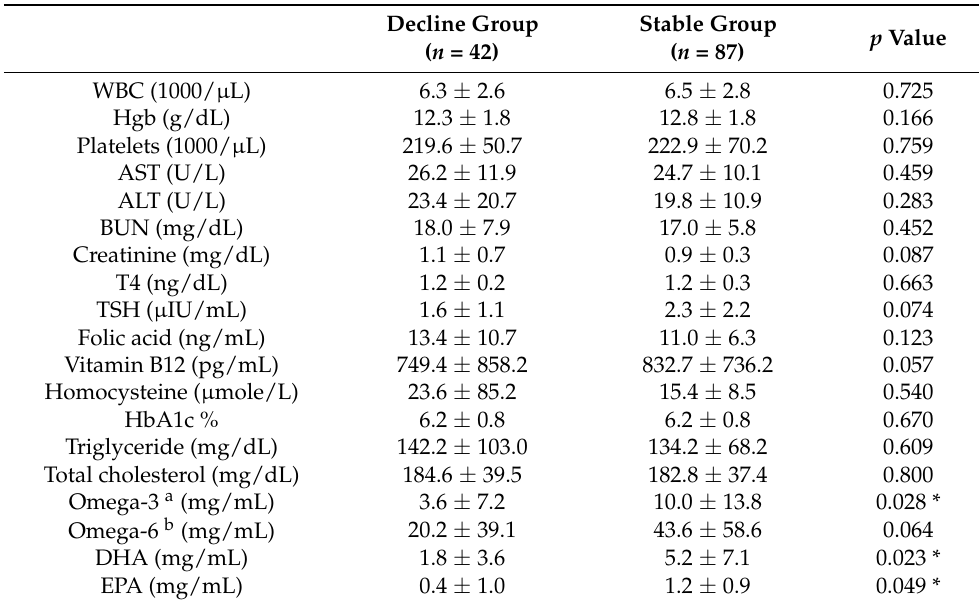
Table 2. Laboratory data of patients with AD receiving AChEIs in two groups.